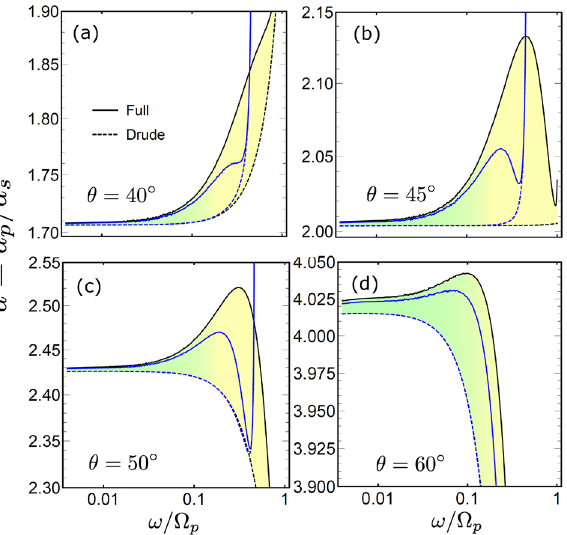
40 45 50 ◦ ( a ), θ = ◦ ( b ), θ = ◦ ( c ) and =